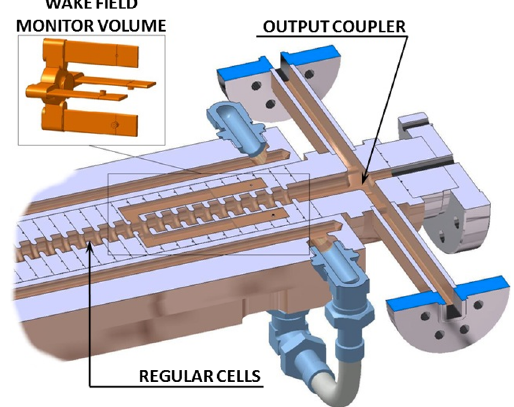
FIG. 43. Cutoff view of the downstream end of the X-band structure showing the location and geometry of the wakefield monitor coupling cell relative to adjacent regular cells, high- power output coupler and cooling circuit [58].